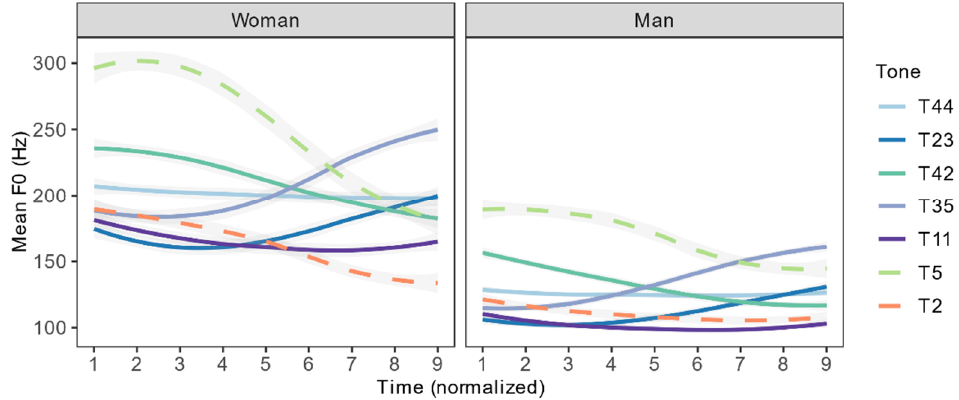
Figure 3. Average F0 track for female and male speakers of the seven tones in Xiapu Min.